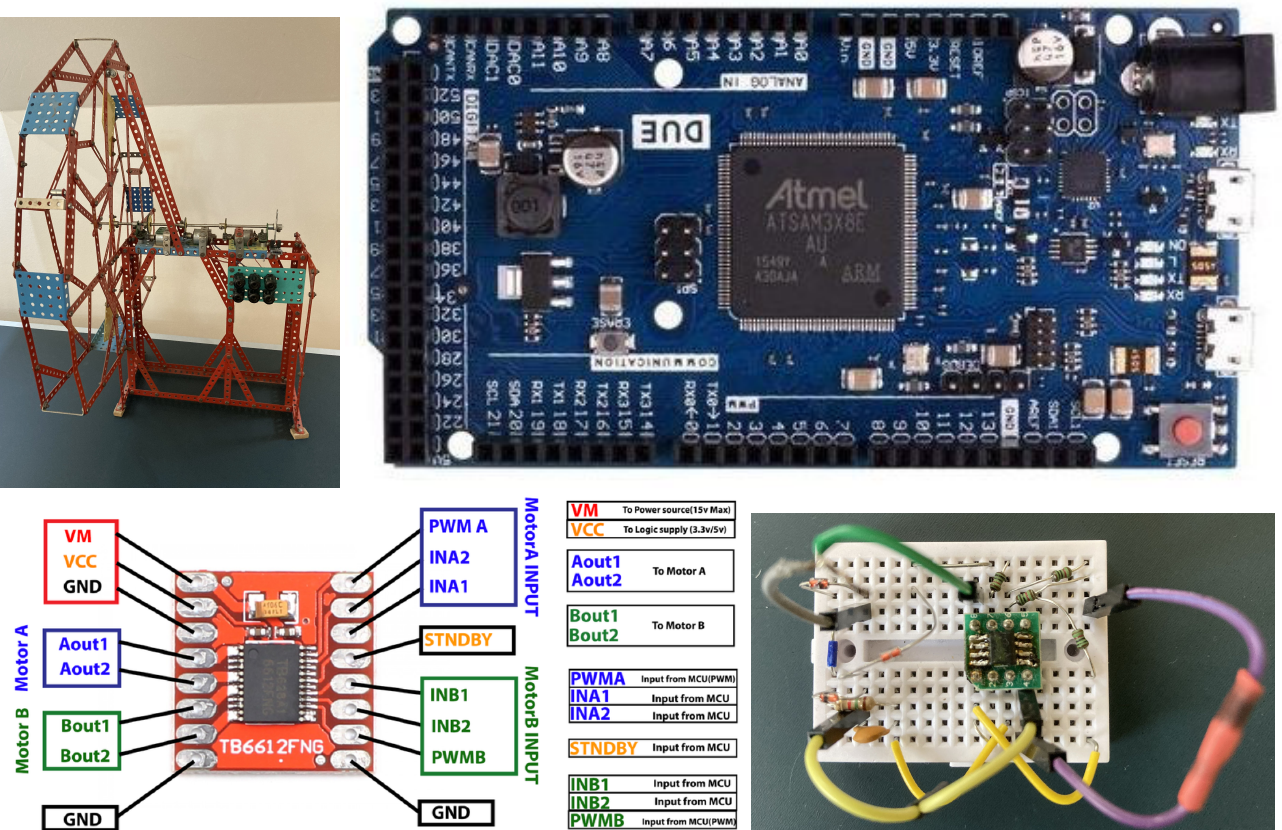
Figure 6. Components of the considered electromechanical Arduino-Due-based speed